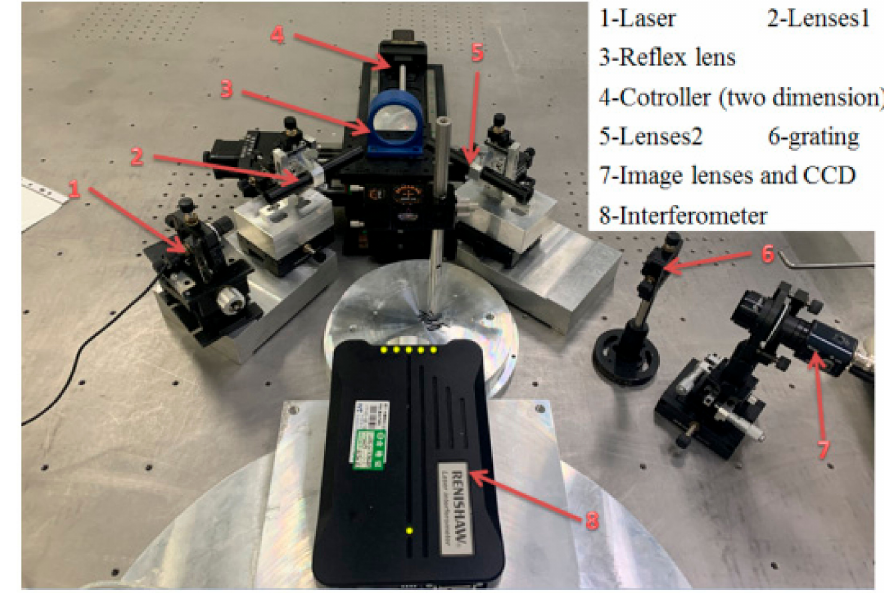
Figure 6. Measurement system for wafer focusing technique (WFT).